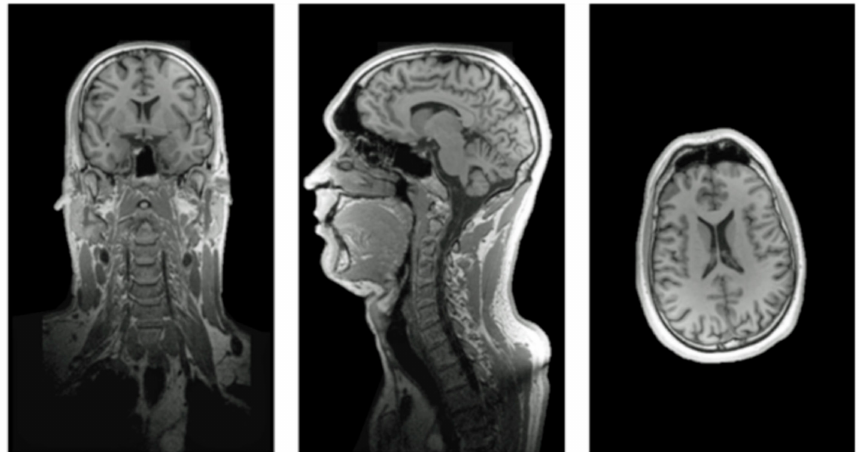
Figure 9. In vivo MR images. First in vivo measurements (MPRAGE images) using the complete device (i.e., RF coil integrated with TxS